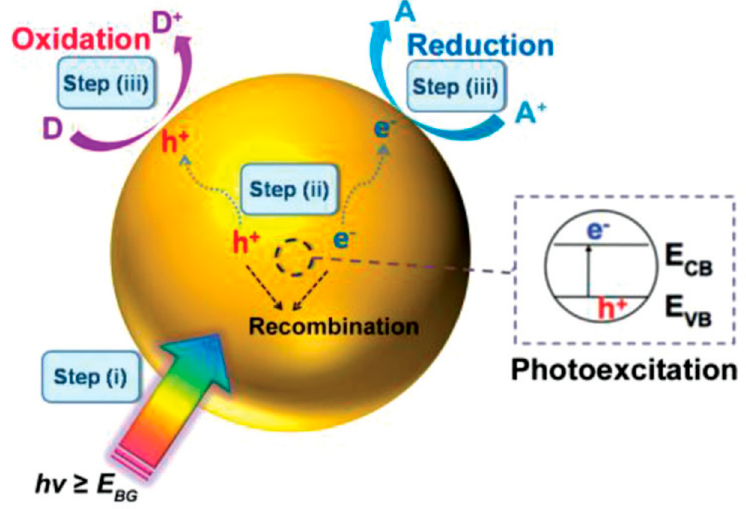
Figure 1. Scheme illustrating the three fundamental stages of the photocatalytic process [2]. Published by The Royal Society of Chemistry.